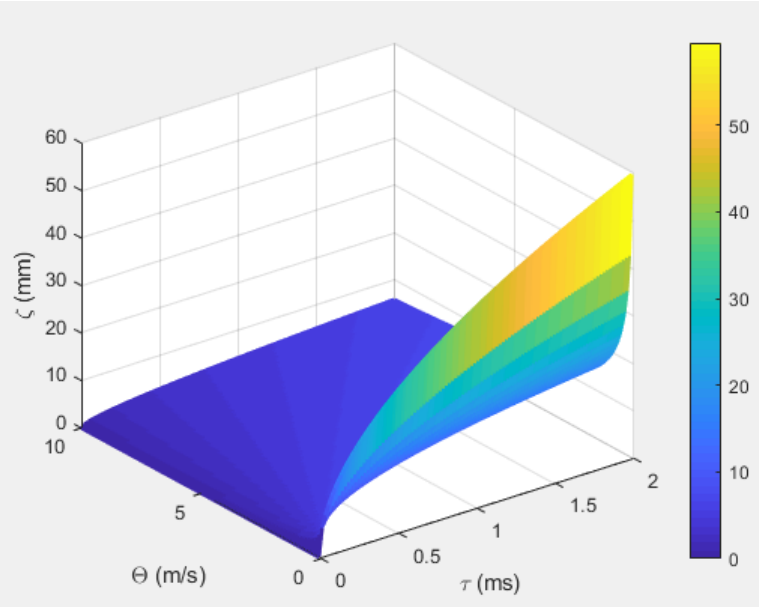
Figure 9. Dynamic impact of half cone